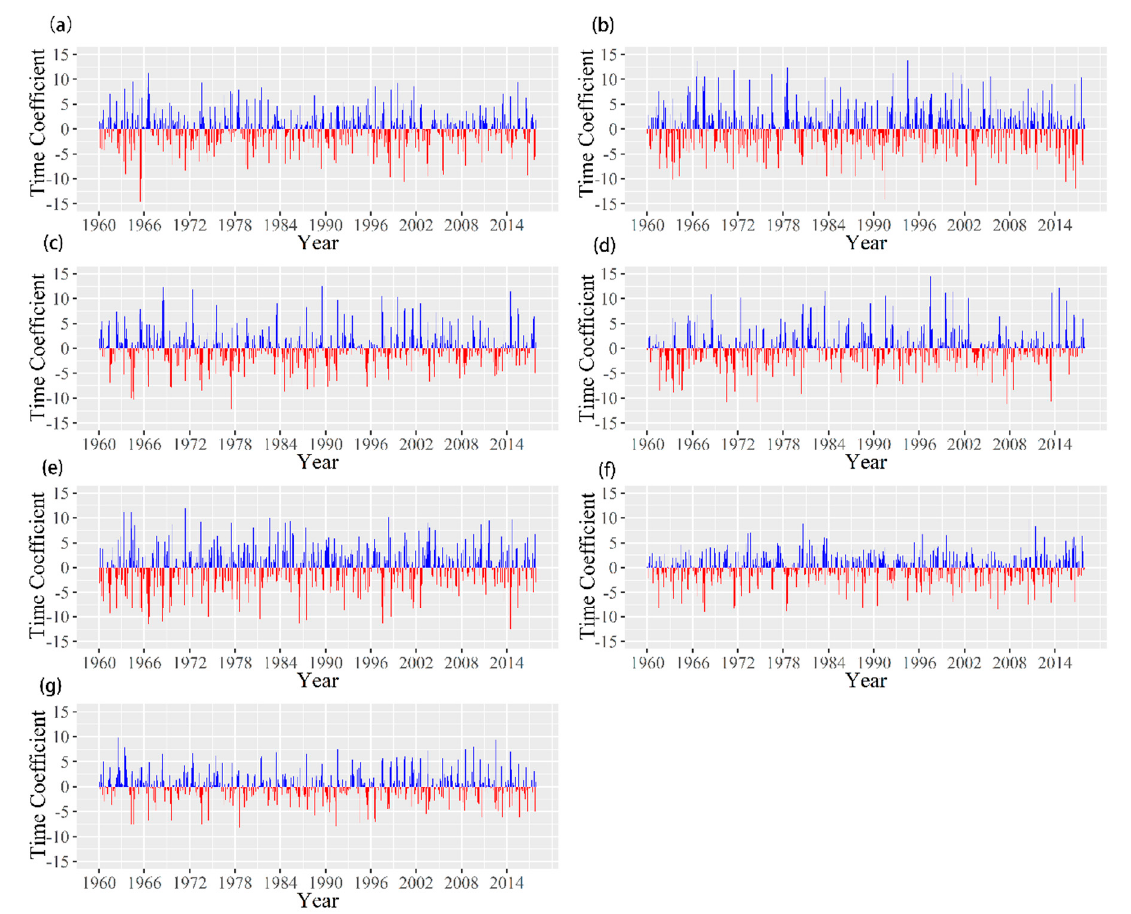
Figure 3. Time coefficients of spatial models of drought variability in the North China Plain. The time coefficient reflects the evolution characteristics of spatial models with time; ( a – g ) represent the time coefficients from model 1 to model 7,